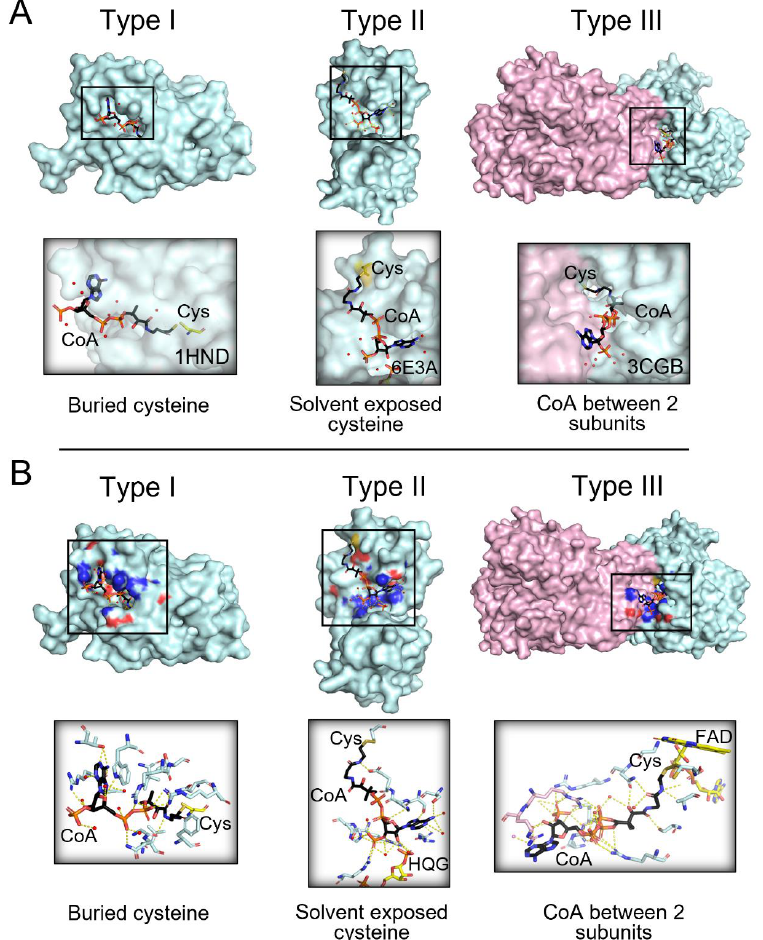
Figure 3. Three main types of CoA binding to modified proteins. ( A ) The three main types of binding to modified proteins are shown. In Type I (e.g., PDB: 1HND — beta-ketoacyl-acyl carrier protein synthase III), CoA is bound to a buried cysteine; in Type II (e.g., PDB: 6E3A — tRNA 2 ′ -phosphotransferase), CoA is bound to solvent exposed cysteine; in Type III (e.g., PDB: 3CGB — CoA disulfide reductase homodimer), CoA is stabilized between two protein subunits. ( B ) Examples of each type of CoAlated protein and the CoA stabilizing interactions are shown. The CoAlated proteins are shown in cyan surface view. In Type III CoAlated proteins, the second protein subunit forming stabilizing interactions is indicated with a pink surface view. For the surface view presentation, the residues interacting with CoA are also shown, where blue represents the nitrogen atoms and red, the oxygen atoms. CoA is shown in a black stick conformation, and water molecules are shown in red balls. Yellow dashes indicate hydrogen bonding between CoA and protein residues and water molecules.